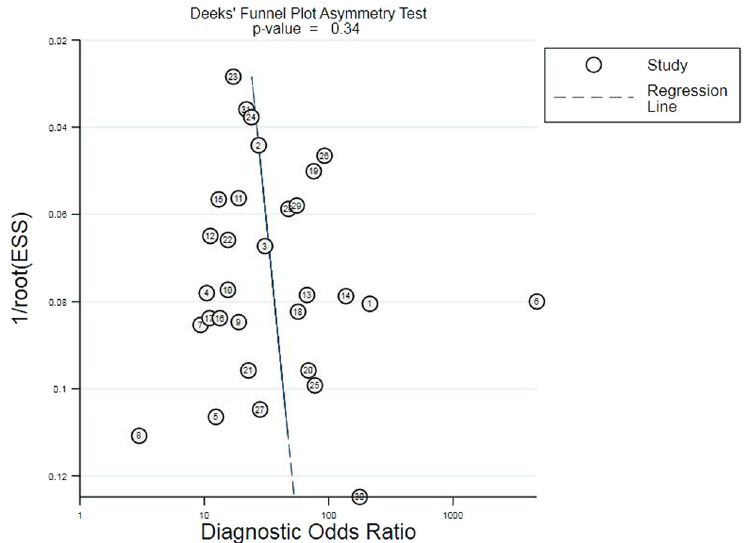
Fig. 4 Deeks ’ funnel plot asymmetry test for evaluation of publication bias. The closer the angle between the regression line of the Deeks ’ funnel plot and the horizontal axis (x) is to 90, the less likely it is to suggest that there is publication bias.